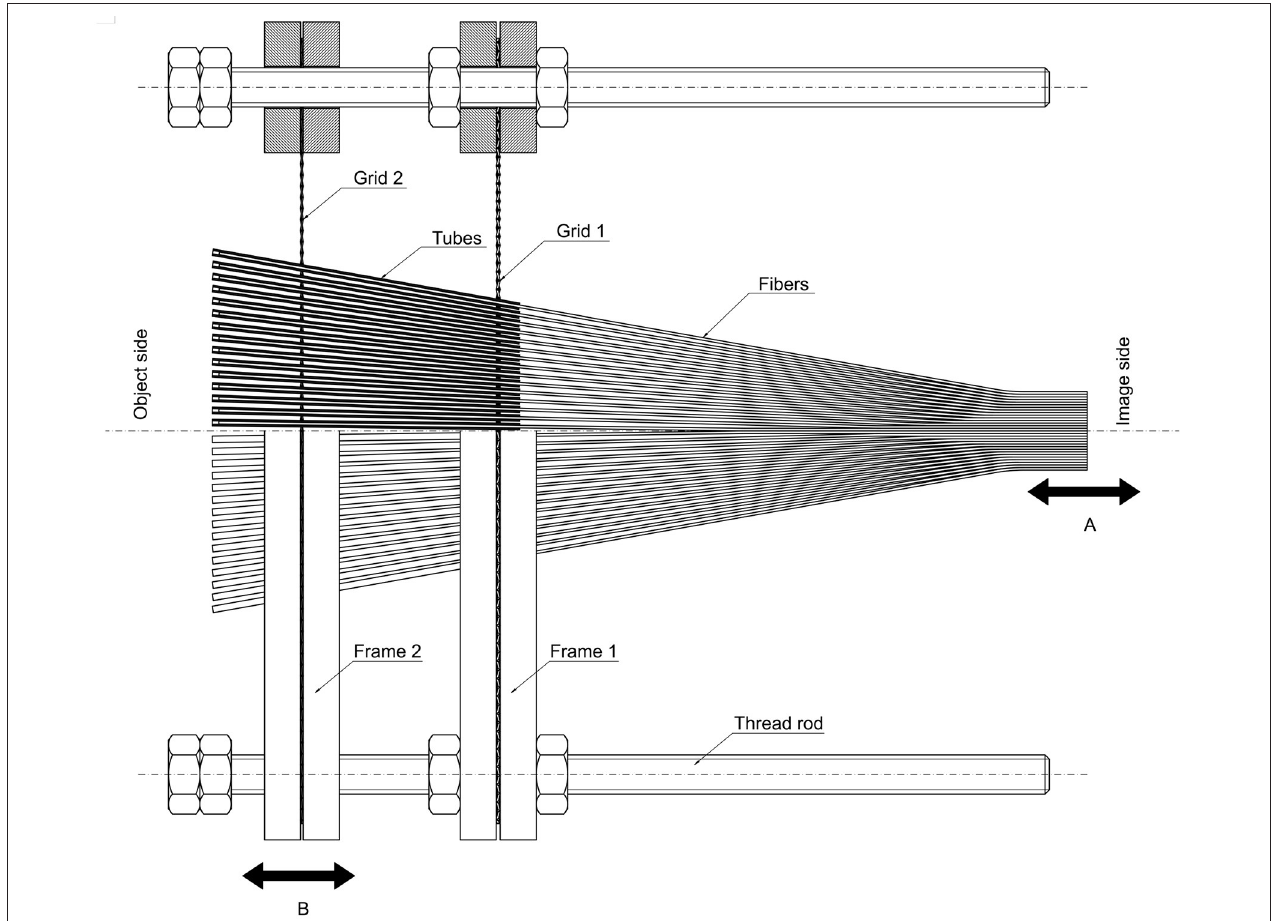
FIGURE 7 | Prototype 1 consists of two grids with different mesh widths. The 30 × 30 tubes, in which the fibers are located, are axially fixed to grid 1. Angle α can be changed by moving the bundle of fibers relative to the tubes (distance A). Grid 2, which has a slightly larger mesh width, can be moved (distance B) so that the angles β between the single tubes are changed. The object is located on the left side of the figure (object side), and its image is detected on the right side of the figure (image side), at the back ends of the fiber